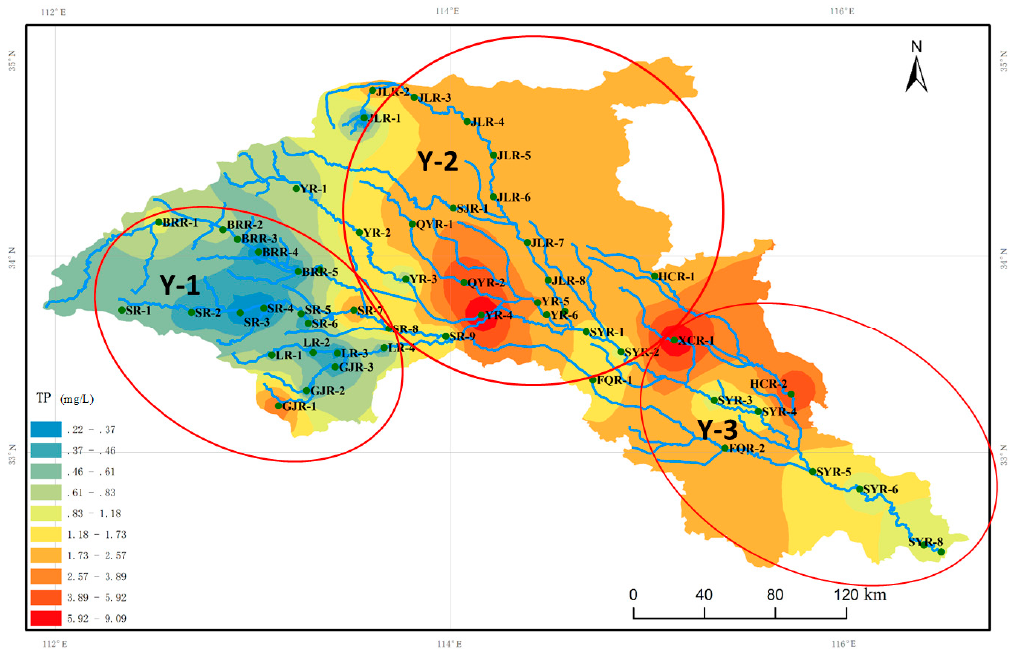
Figure 5. Total nitrogen (TN) NH 3 -N, and Total phosphorus (TP) distribution in the Ying River.